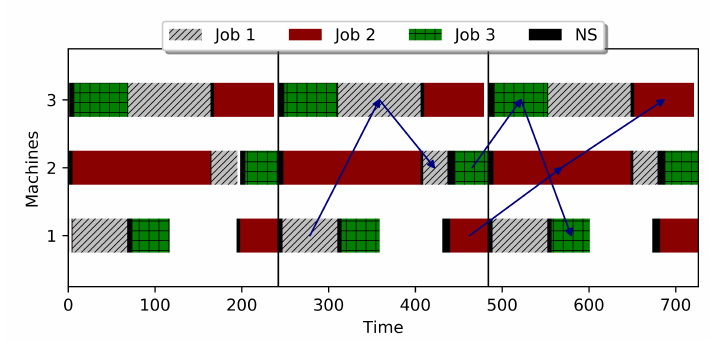
Figure 9. The Gantt chart of three consecutive cycles for the considered instance problem; blocking CJSS problem with sequence-dependent nonanticipatory setups